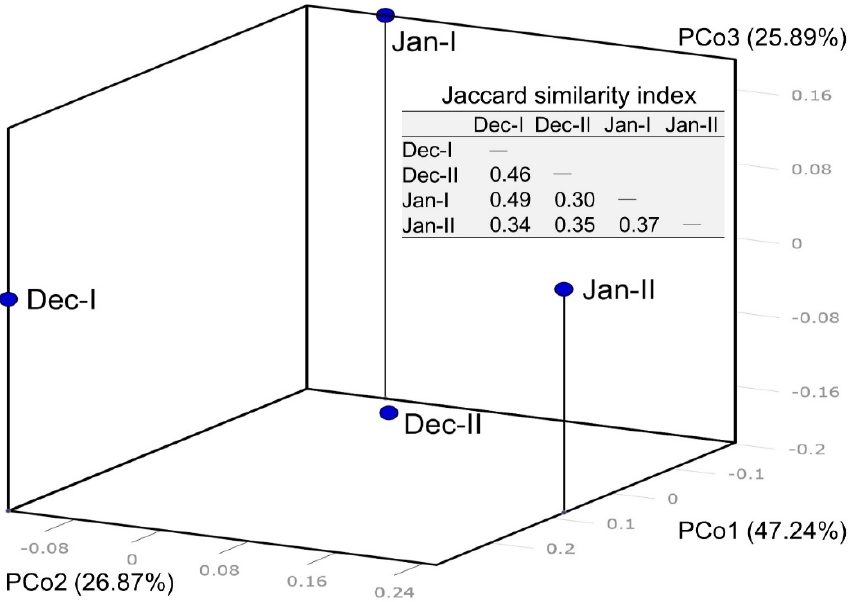
Figure 2. β -diversity patterns of fish species from 4 eDNA samplings (December-I, December-I, January-I, January-II) as inferred from Principal Coordinate Analysis (PCoA). The similarity matrix was obtained by the Jaccard similarity index.